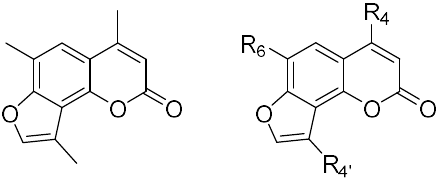
Figure 1. General structure of TMA and TMA analogues.